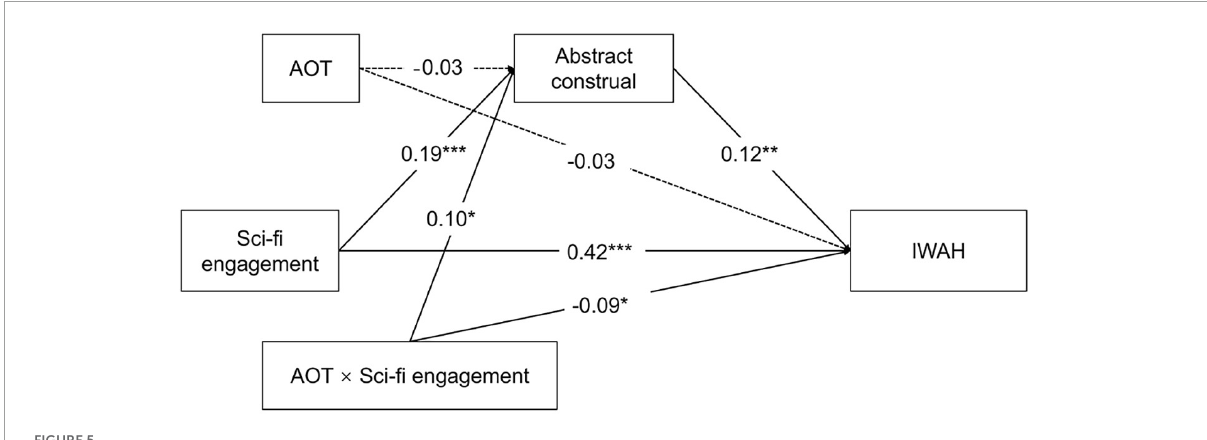
FIGURE5 Results of the moderated mediation analysis. *** p < 0.001, ** p < 0.01, * p < 0.05; IWAH, Identification with all humanity; AOT, Actively open-minded thinking.